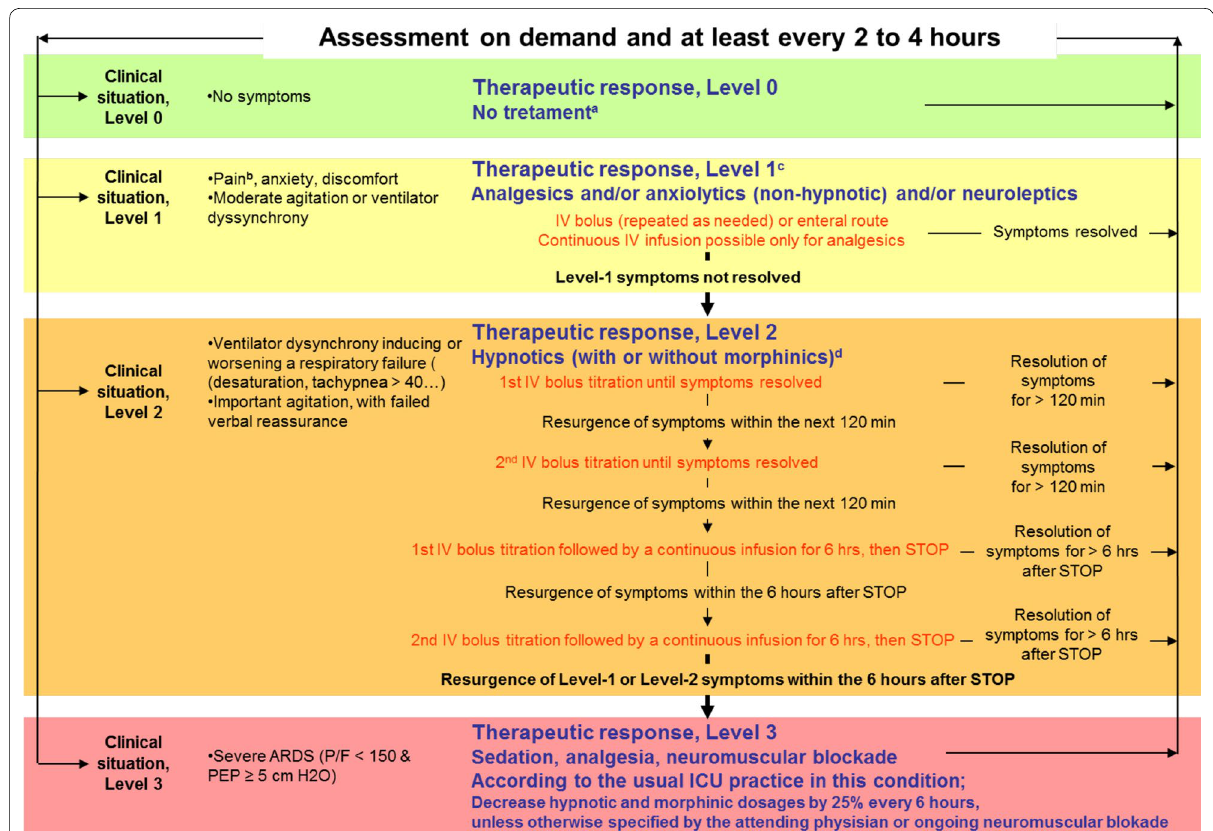
Fig. 1 Oversedation prevention (OSP) strategy was centred on patients’ level of agitation, ventilator dyssynchrony, and pain, assessed on a 4-level scale, with gradual on-demand responses, frequent reassessments, and promotion of alternatives to continuous around-the-clock infusion of intravenous hypnotics. These alternatives included frequent (every 6 h) intravenous hypnotic interruptions, intravenous boluses of hypnotics without continuous intravenous infusion, and the use of non-hypnotic drugs, including neuroleptics, hydroxyzine, and anxiolytic benzodiazepines. The choice of the non-hypnotic drugs and their route of administration (intravenous boluses or nasogastric tube) were left to the preference of the attending physician. There was no restriction for the use of morphinics and non-morphinic analgesics. Patient at Level 0, who showed no discomfort, received no treatment, or continuation of a successful level-1 therapeutic response ( a ). Patient at Level 1, with only moderate discomfort, pain, or anticipated procedural pain ( b ), received any form of analgesics as deemed necessary by the attending physician and/or non-hypnotic drugs as well as verbal reassurance and, if appropriate, changing of ventilator settings ( c ). Patients at Level 2, with severe agitation or ventilator dyssynchrony first received repeated intravenous boluses of either propofol or midazolam according to physician preferences, and, if discomfort persisted, 6-h continuous intravenous infusion of midazolam or propofol. This treatment was also applied in case of Level 1 therapy failure (which was maintained or stopped according to physician preference ( d ). Patients at Level 3, with ARDS and a PaO 2 /FiO 2 ratio < 150 mmHg, were treated with a continuous intravenous infusion of midazolam or propofol, with neuromuscular blocking agents administered according to physician preference. This treatment was also applied in the case of Level 2 therapy